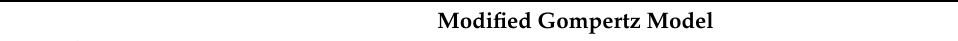
Figure 5. Cumulative methane yields from digestate ultrasonicated under different specific energy inputs. Table 1. Kinetic parameters estimated with biochemical methane potential (BMP) test data fitting. TS: total